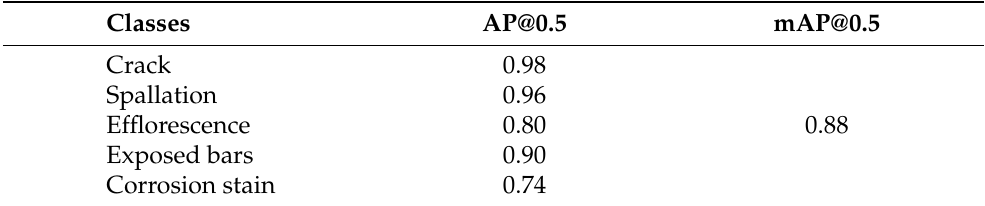
Table 1. Results of the SMDD-Net evaluation on the test set without using the attention module.